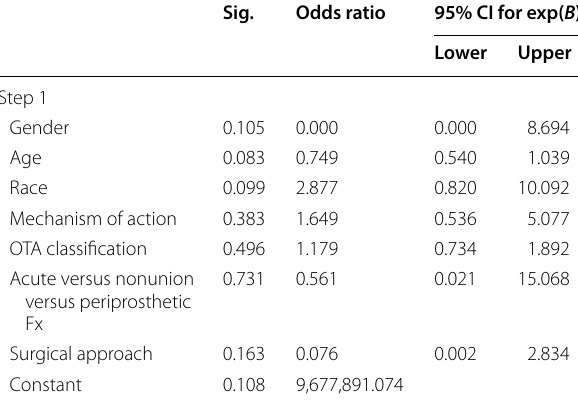
Table 3 Factors associated with nerve recovery